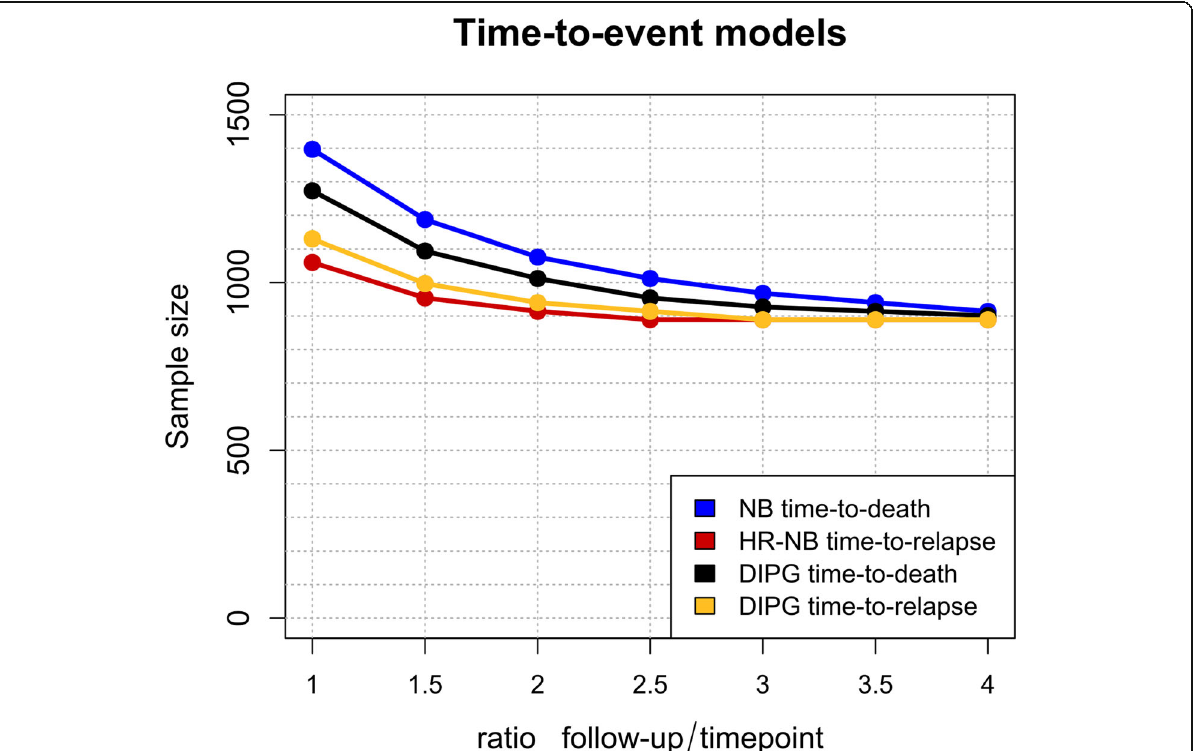
Fig. 3 How the follow-up/timepoint ratio affects the sample size. Analysis of the variation in sample size for the time-to-event models relative to the ratio between the expected average follow-up of the dataset and the time points of interest for the predictions. DIPG diffuse intrinsic pontine glioma, HR high-risk, NB neuroblastoma